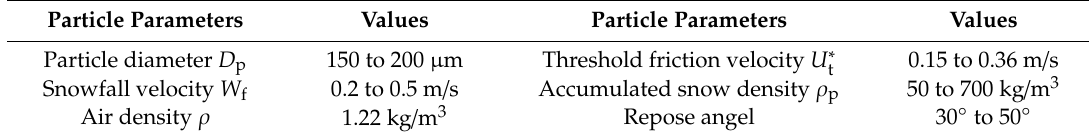
Table 1. Prototype drifting parameters.